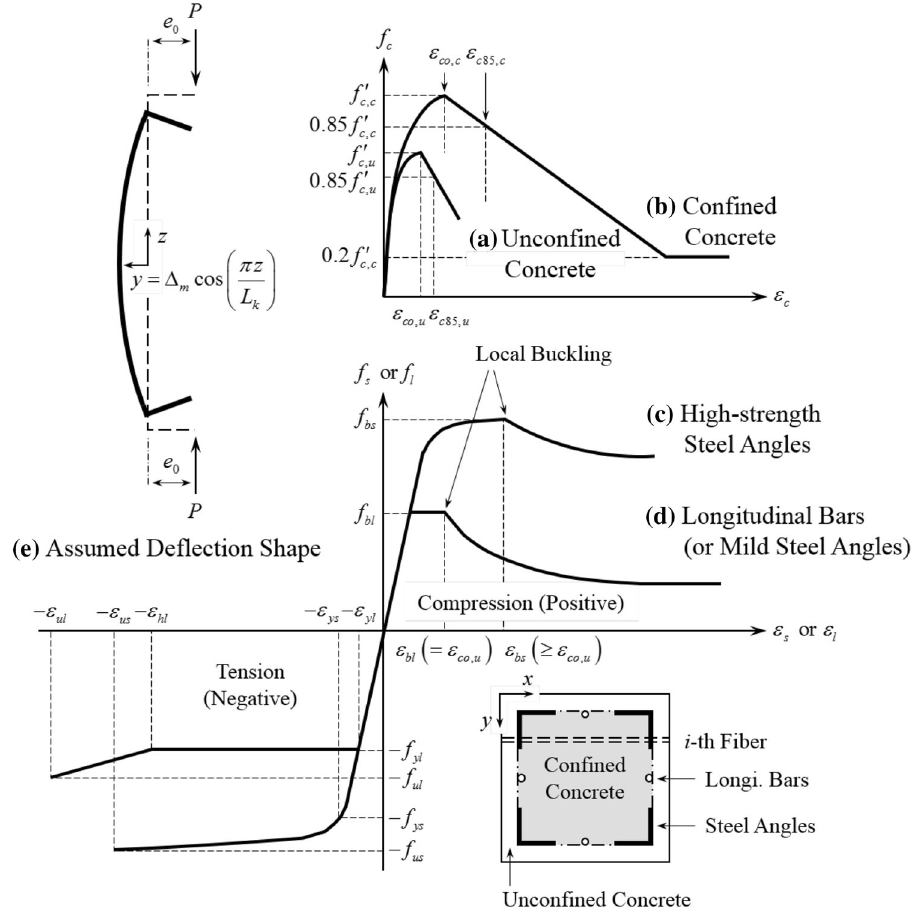
Fig. 4 Material, section, and geometry models for nonlinear numerical